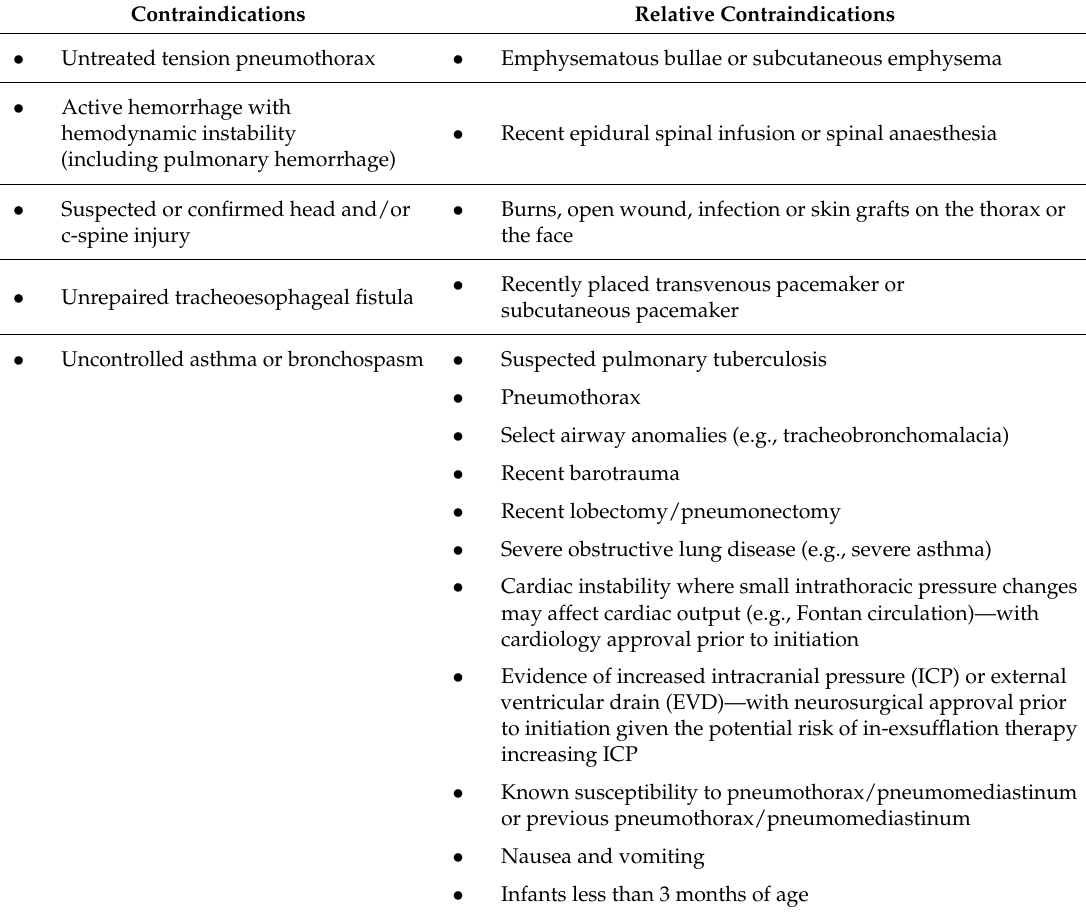
Table 3. Contraindications for mechanical in-exsufflation